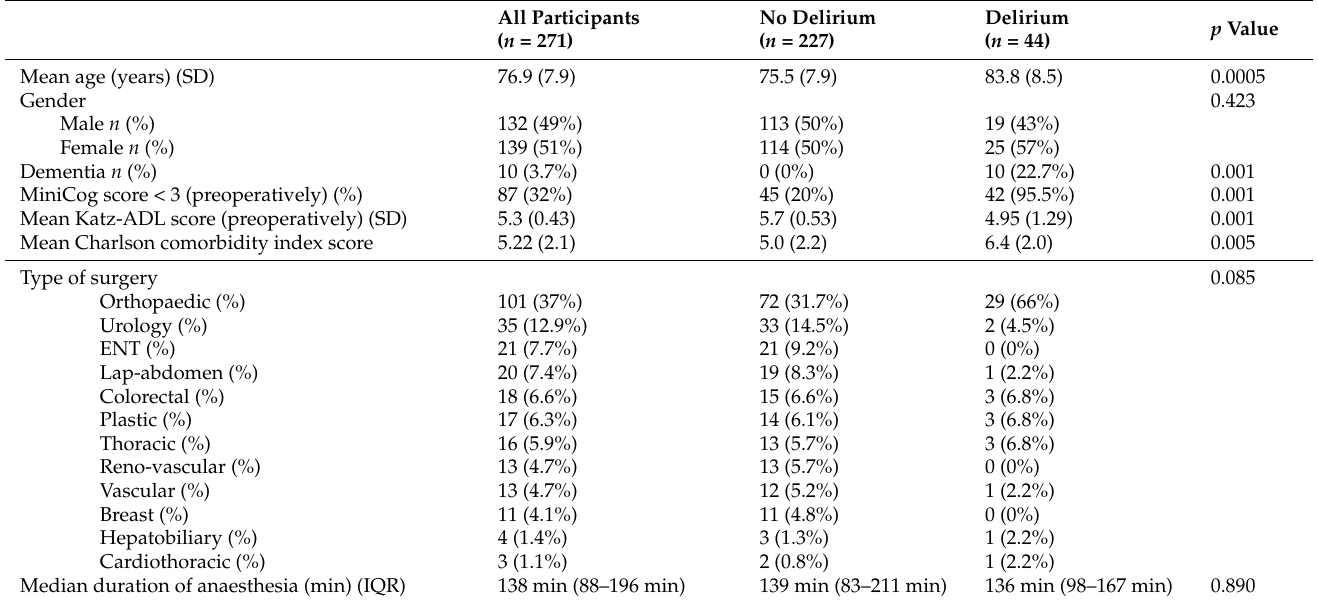
Table 1. Baseline characteristics of participants by delirium diagnosis DSM-5 (definite delirium).